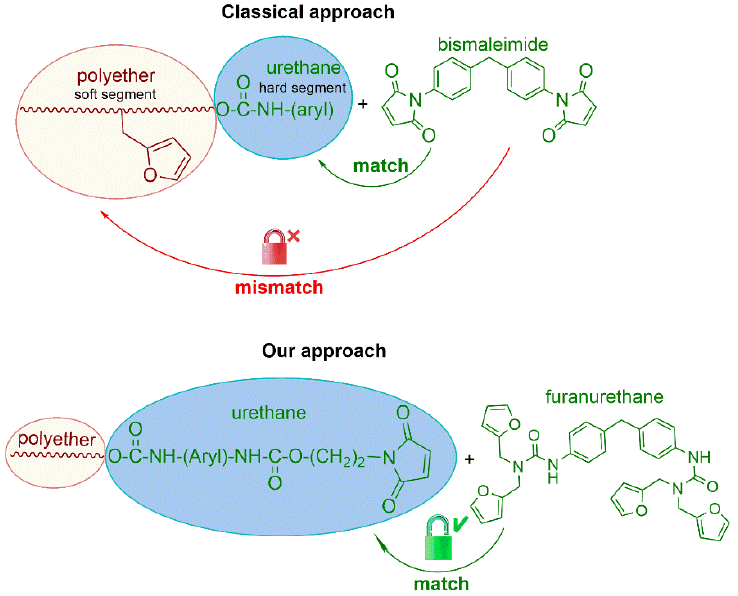
Figure 1. Schematic representation of the strategy used for the synthesis of self-healing polyure-